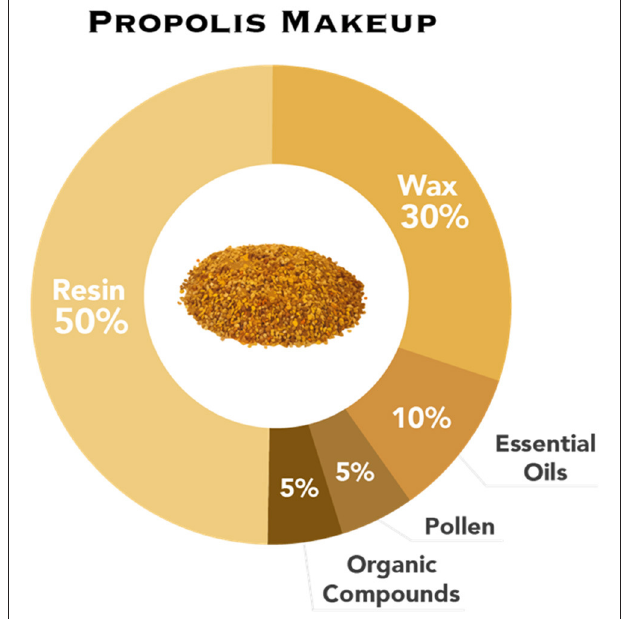
FIGURE 1 | The composition of propolis: resin, wax, essential oils, pollen, and organic